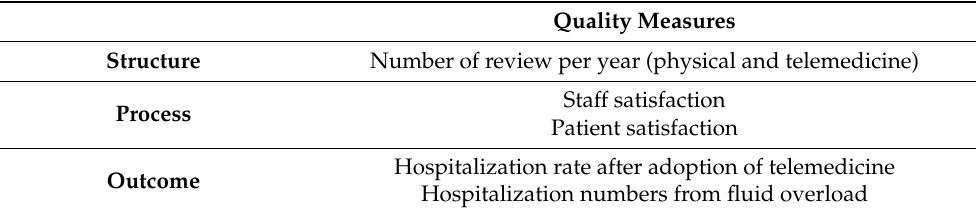
Table 1. Quality measures telemedicine in dialysis unit in the Singapore